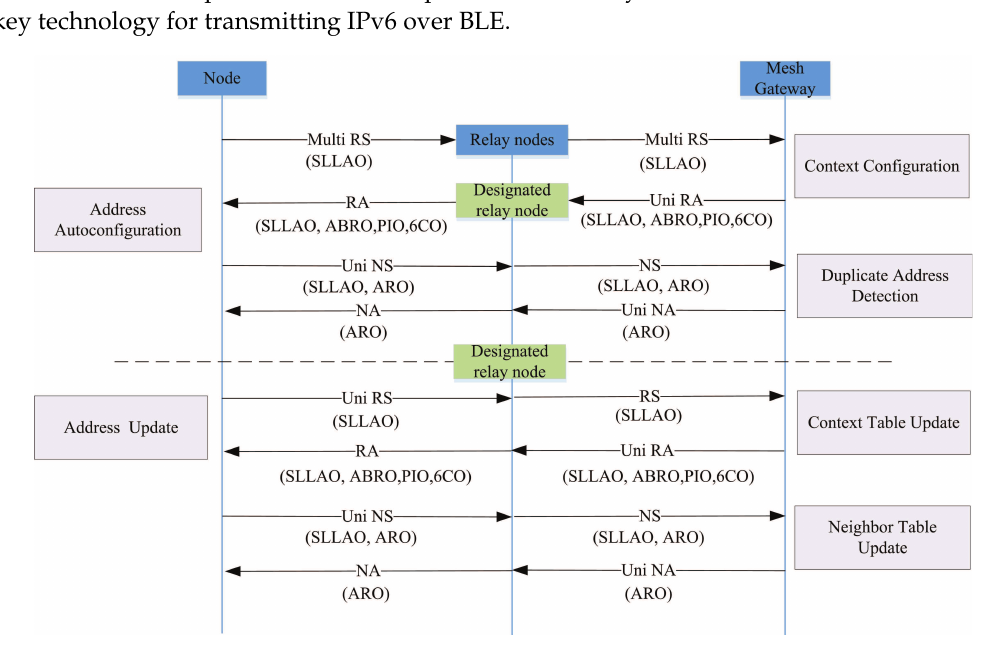
Figure 4. IPv6 address auto-configuration and update